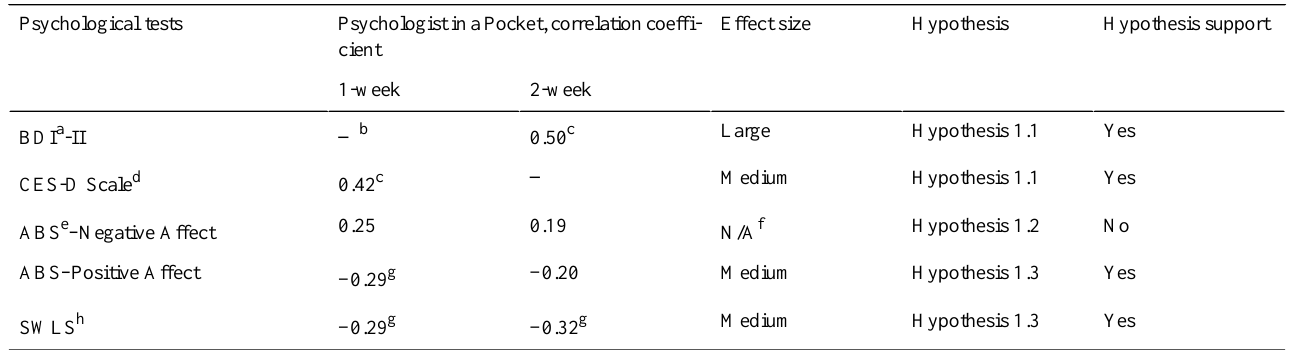
Table 6. Construct validation results (correlation coefficient) and hypothesis (N=53 for all